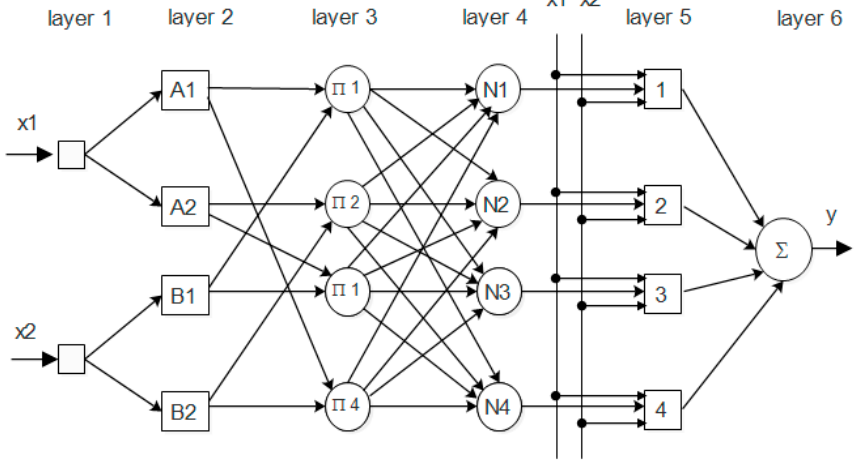
Figure 2. Adaptive neuro-fuzzy inference system (ANFIS) structure for prediction.